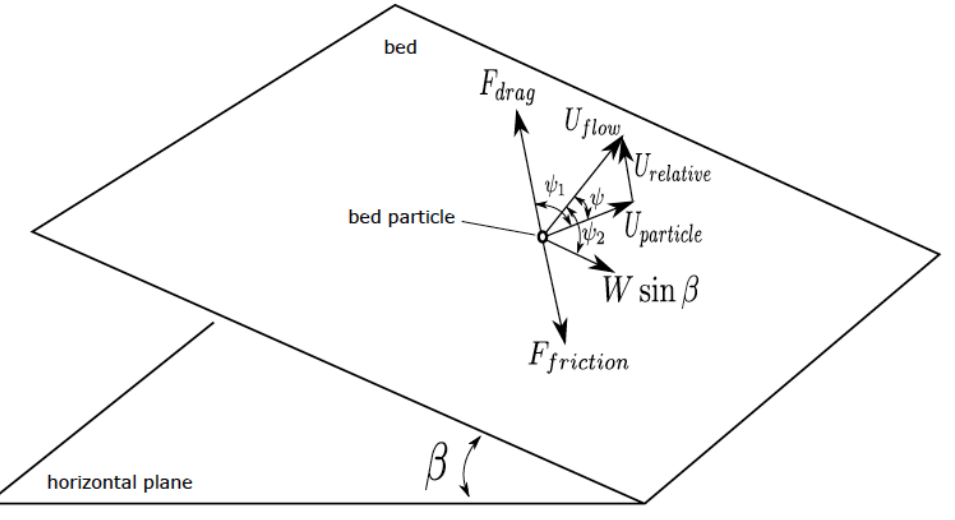
Figure 5. Forces on a bed particle and their geometric